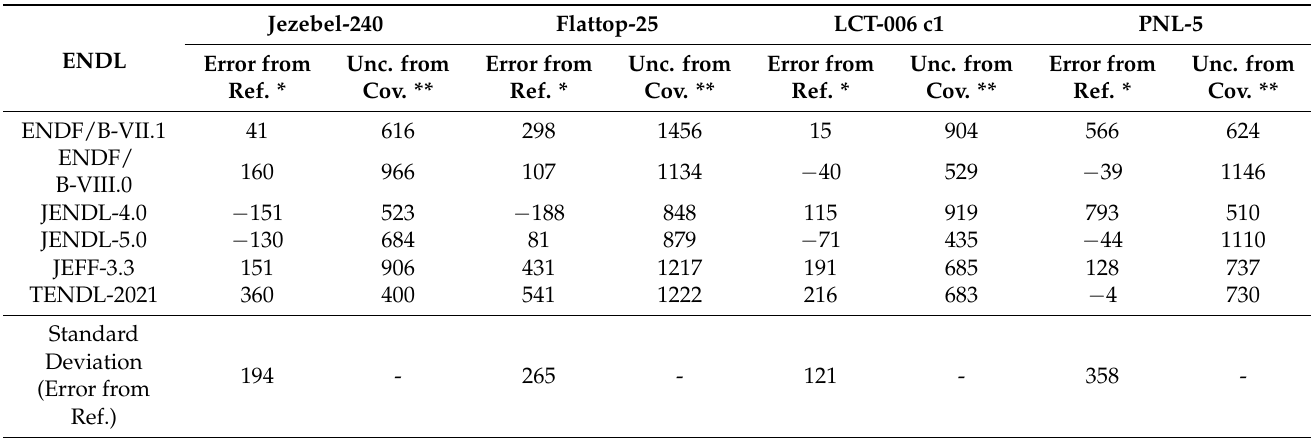
Table 8. Error of k eff from reference and uncertainty of k eff due to the uncertainty of cross sections for the four ICSBEP